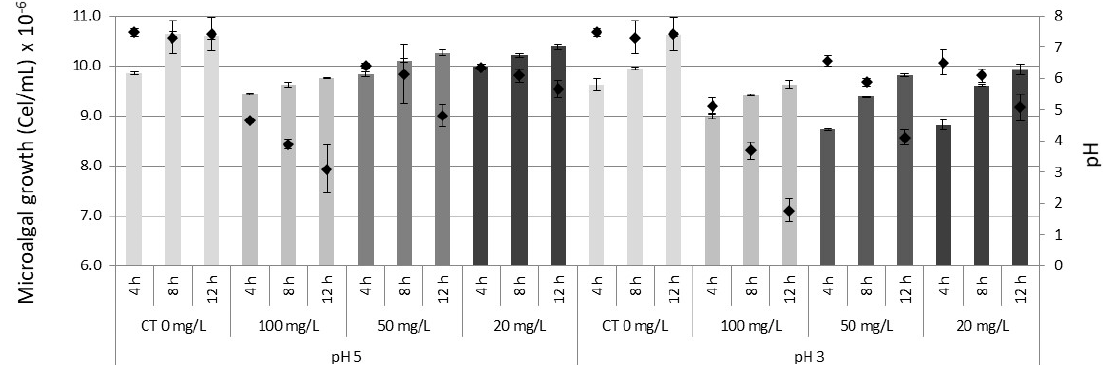
Figure 1. Growth of the microalga Muriellopsis sp., In artificial acid drainage (AAD) cultivated at different pH and copper concentrations. CT (Control). The bars represent ± standard error of the mean. Diamond symbol microalgal growth.